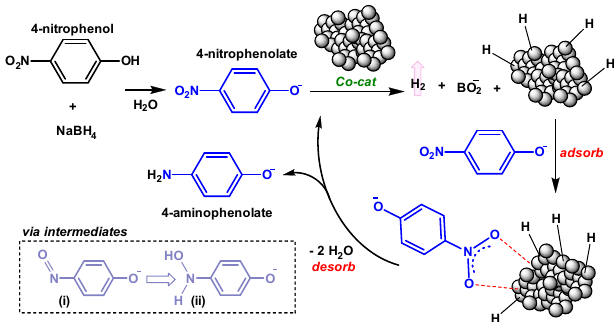
Figure 5. Proposed general mechanism for the reduction of 4NP with catalysts Co@100, Co@350, and Co@600 in H 2 O with excess NaBH 4 .